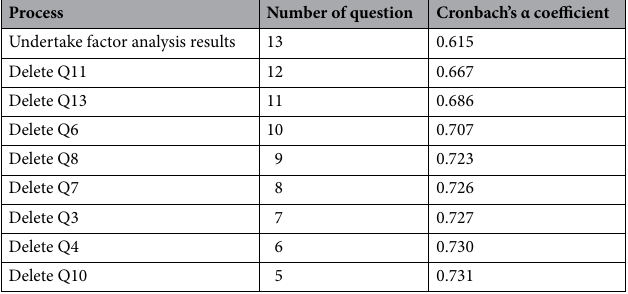
Table 4. The Cronbach’s α coefficient of the deleted